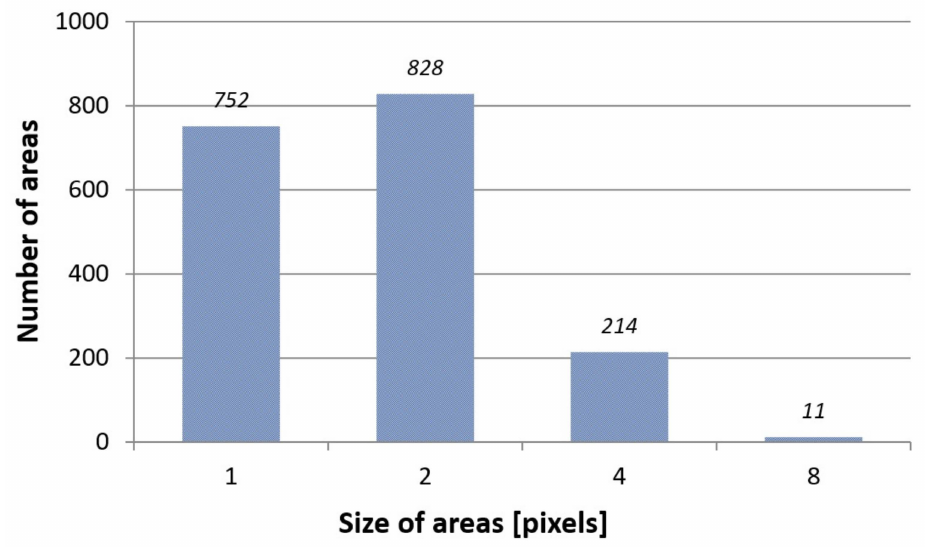
Figure 10. Histogram of the number of square areas in quadtree decomposition for the brightness threshold of one sample